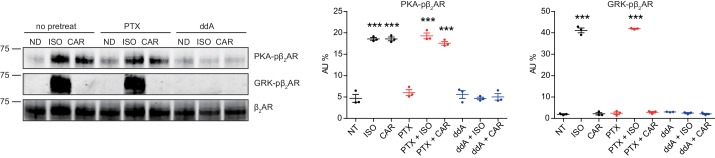
Carvedilol-induced β2AR phosphorylation is AC-dependent.HEK293 cells stably expressing FLAG-tagged β2AR were pretreated with the Gi inhibitor pertussis toxin (PTX, 200 ng/ml, 16 hr) or the adenylate cyclase inhibitor 2',5'-dideoxyadenosine (ddA, 50 μM, 30 min) and then stimulated with 100 nM isoproterenol (ISO) or carvedilol (CAR) for 5 min. The phosphorylation levels of β2AR on its PKA and GRK sites were determined with phospho-specific antibodies, and signals were normalized to total β2AR detected with anti-FLAG antibody. Experiments were performed in the presence of 1 μM β1AR-selective antagonist CGP20712A to block endogenous β1AR signaling. P values are computed by one-way ANOVA followed by Tukey’s test between no drug (ND) and other drugs within the same group. Data are the mean ± s.e.m. of three experiments.